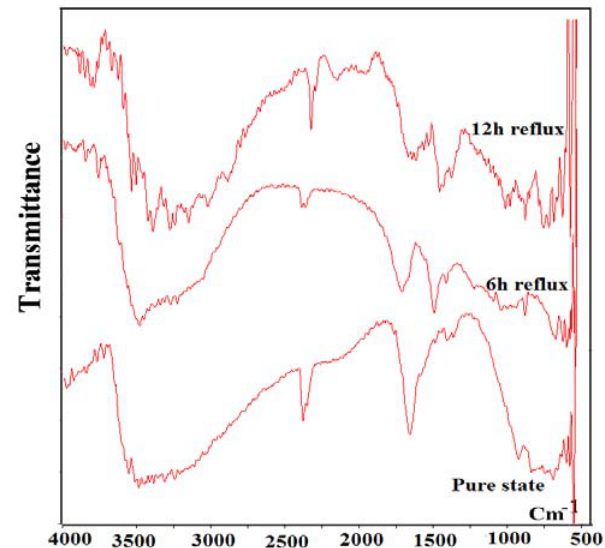
Fig. 7. FTIR spectra of pure and Al-doped TiO nanorods with 6 h reflux time and 12 h reflux